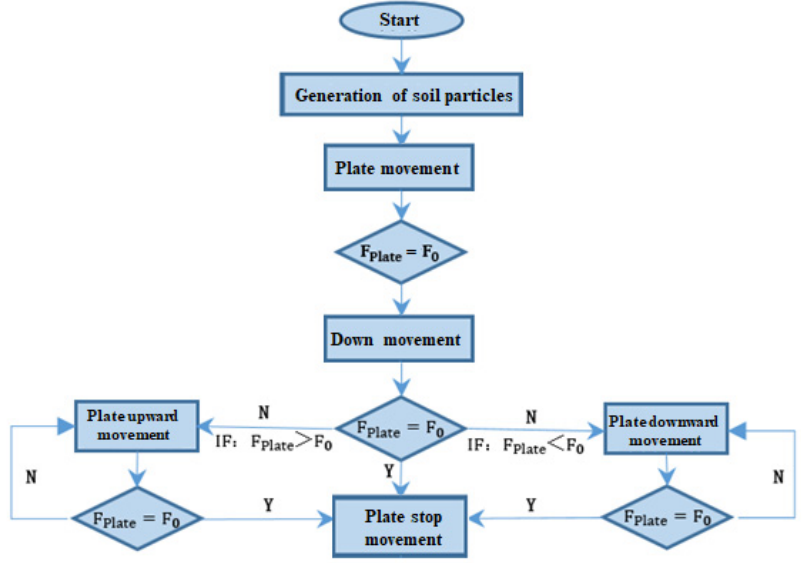
Figure 11. Flow chart of shear box working procedure.